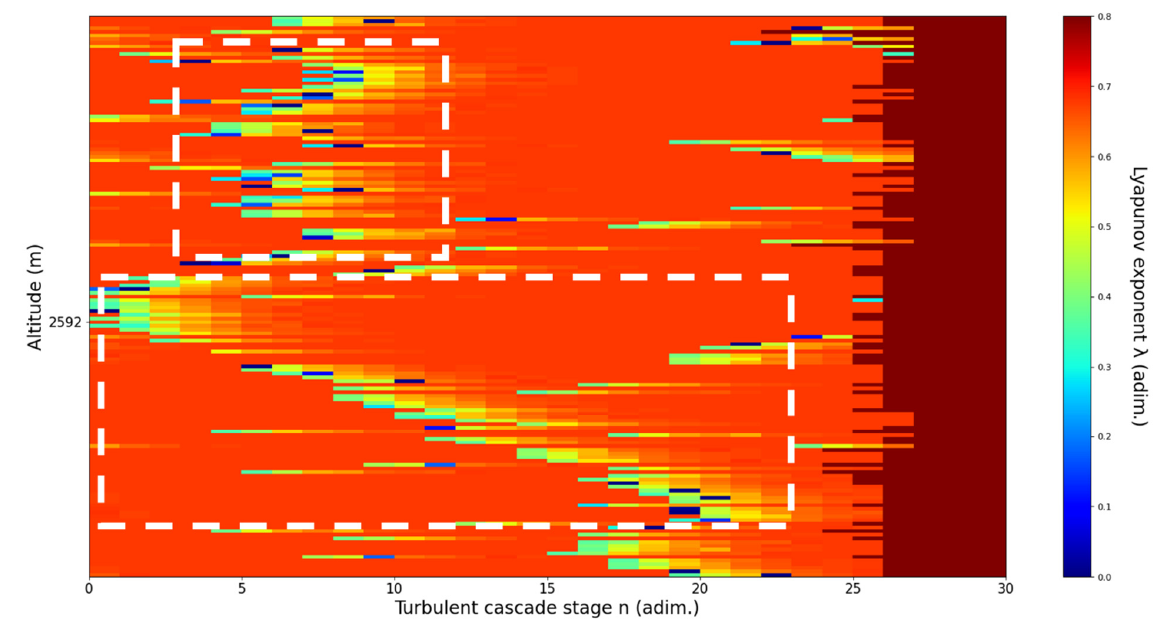
Figure 22. Lyapunov exponent per turbulent cascade stage colormap altitude plot, Bucharest, Romania, 13 June 2019,